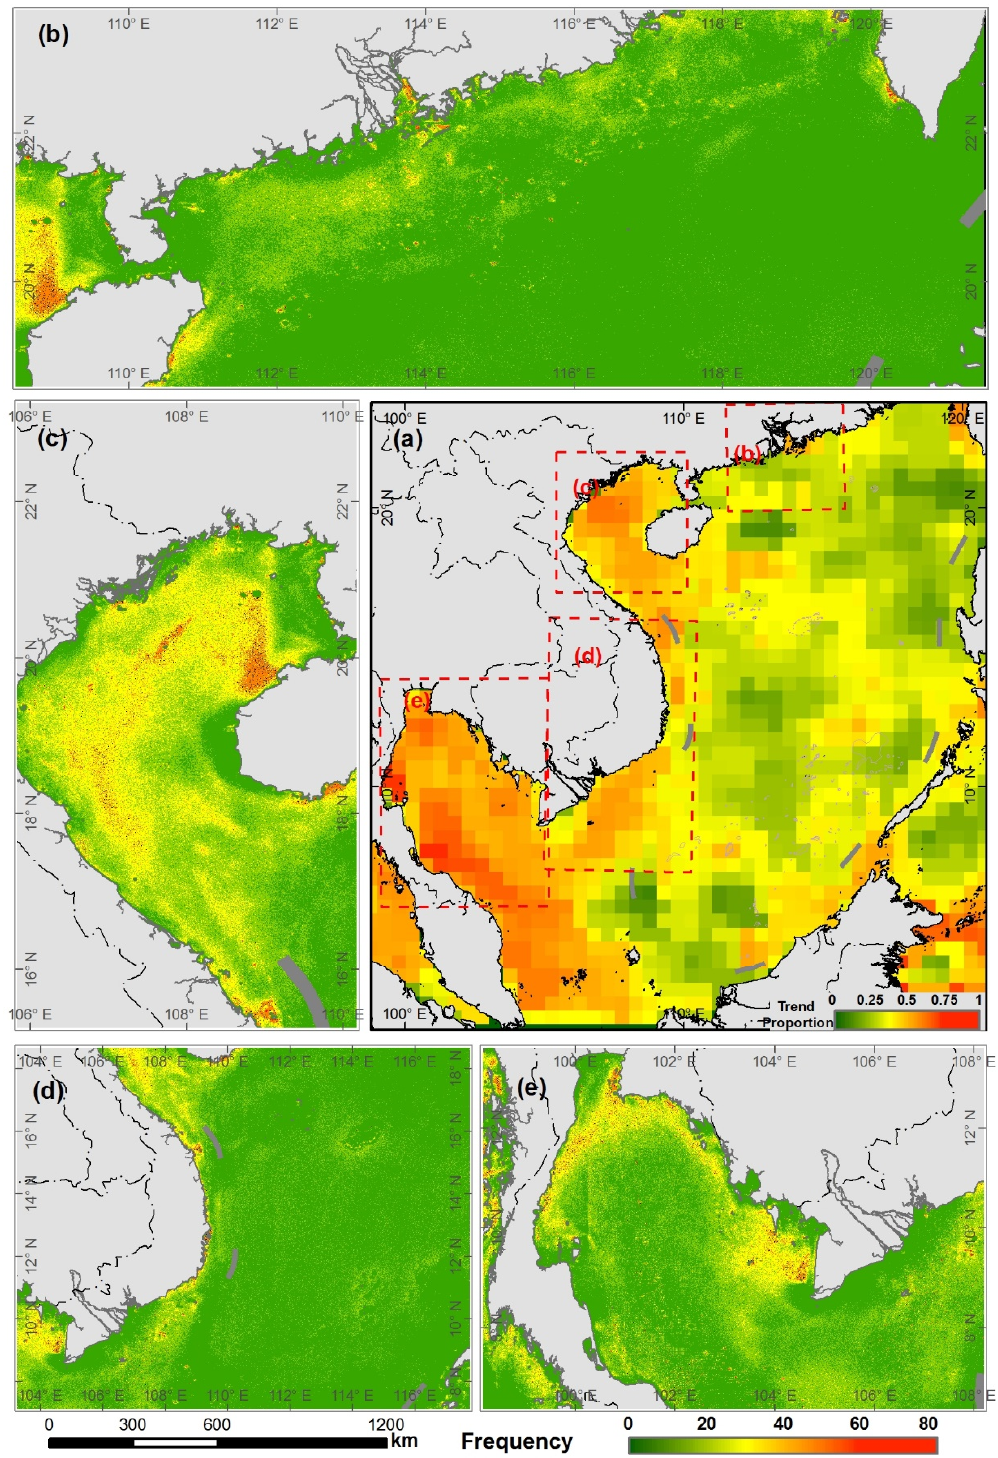
Figure 10. Location map of selected subregions: ( a ) The spatial distribution of trend slope in the SCS. The occurrence frequency of nighttime fishing activity in ( b ) Pearl River ( c ) Gulf of Tonkin ( d ) Eastern Vietnam ( e ) Gulf of Thailand.